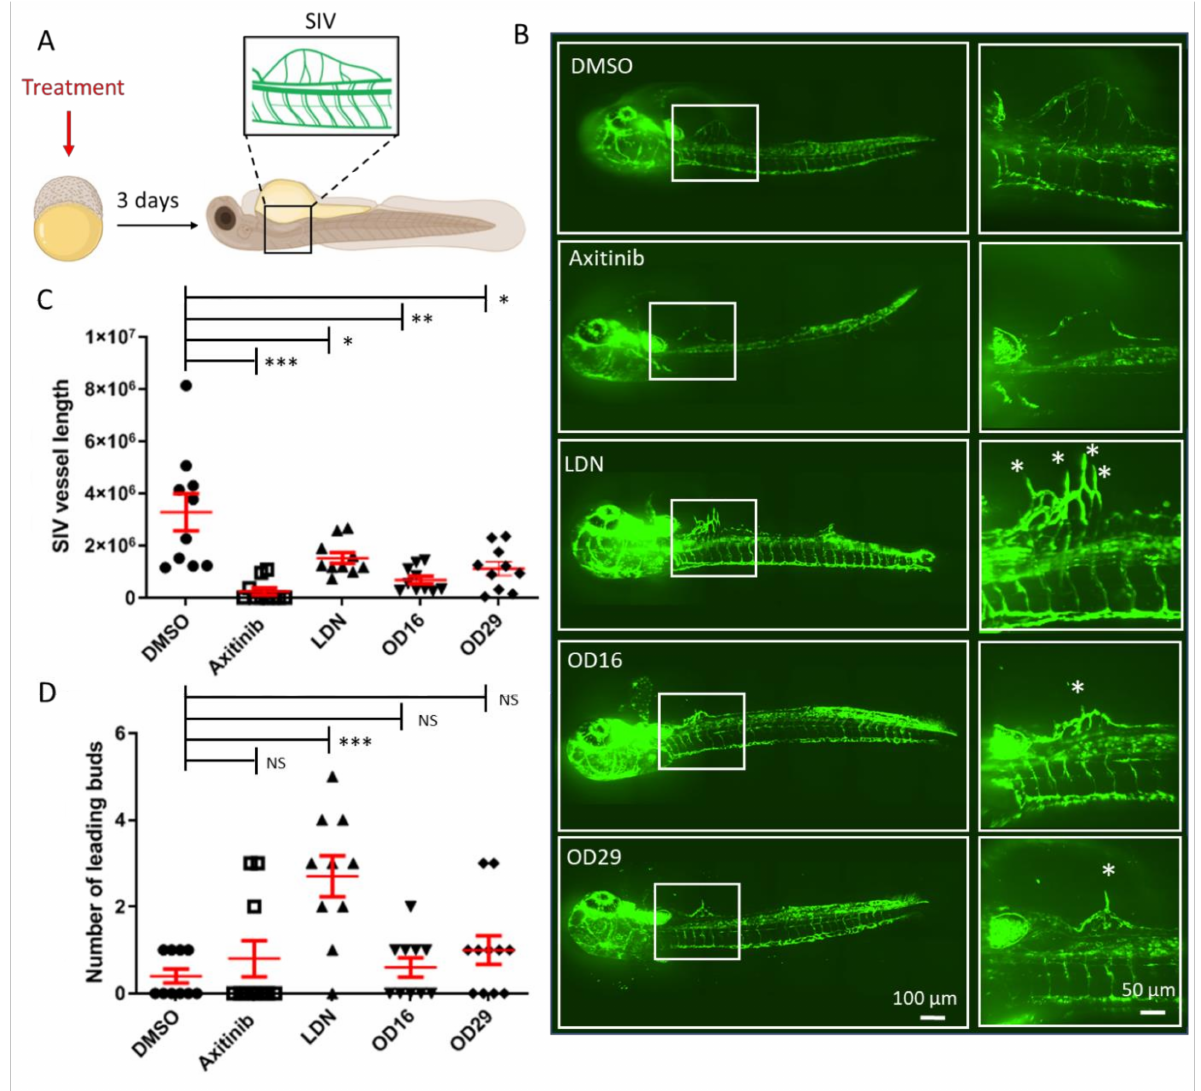
Figure 6. OD16 and OD29 inhibit subintestinal vessel (SIV) formation in transgenic Casper zebrafish line Tg ( fli :EGFP). ( A ) Schematic representation of the experimental procedure. Freshly collected 2.5 hpf embryos were challenged with testing compounds in egg water. The SIV vascularization was analyzed after 3 days of treatment. ( B ) Effects of OD16, OD29, Axitinib, and LDN-193189 at 0.5 µ M, or vehicle control (DMSO) on zebrafish SIV development. Compounds were added to egg water for 3 days before observing the SIV vascularization. Representative images of overview (left panel) and high magnification (white rectangle areas from left) are shown. Asterisks represent sprouting vessels. Scale bars represent 100 and 50 µ m. ( C ) Quantification of the SIV vessel length of the zebrafish embryos in each group from the experiment shown in ( B ). * p < 0.05, ** p < 0.005, *** p < 0.001. ( D ) Quantification of the number of leading buds (indicated as asterisks in panel B). *** p < 0.001. NS, not